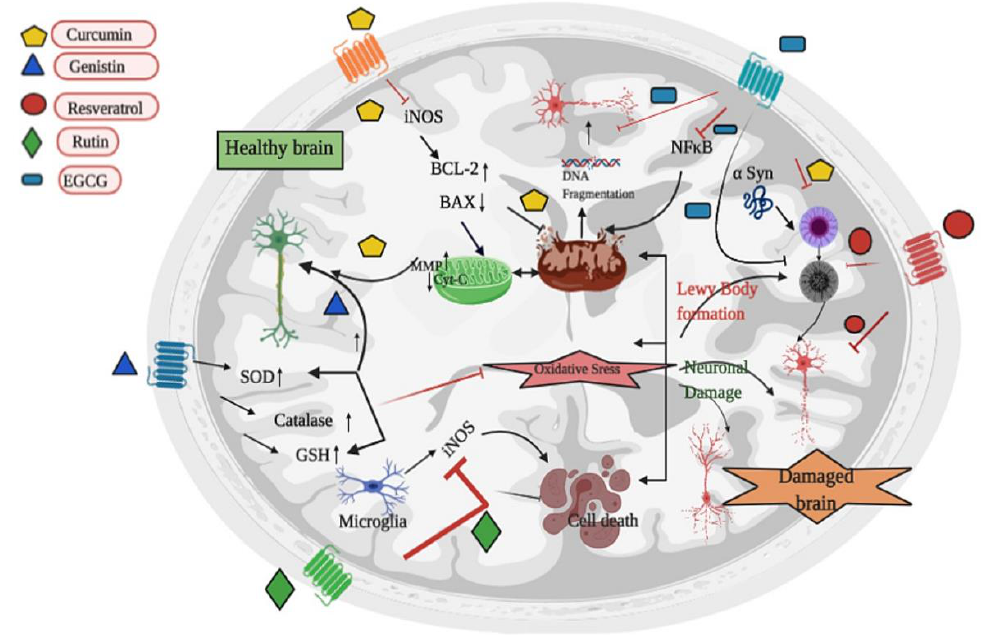
Figure 4. Diagrammatic presentation of Parkinson’s disease, cause, and role of phytochemicals to reverse the sign of PD. Mitochondrial dysfunction, oxidative stress, and uncontrolled cell death leads to the accumulation of Lewy bodies and resultant neuronal damage. Phytochemicals function with multiple targets. Curcumin targets the inducible nitric oxide synthase (iNOS) and regulates the ratio of BCL-2 / BAX which leads to the restoration of mitochondrial function. Genistin increases the activity of SOD, Catalase, and GSH and protect the neurons from damage ignited by oxidative stress. Resveratrol inhibits the formation of Lewy body (aggregation of α -syn protein-a major cause of PD). Rutin protects the neuron by leading the anti-inflammatory pathway and EGCG inhibits the transcriptional factor NF κ B and restores the normal function of mitochondria. EGCG also plays a role to inhibit DNA fragmentation. All over the activities of phytochemicals escape neurons from damage.